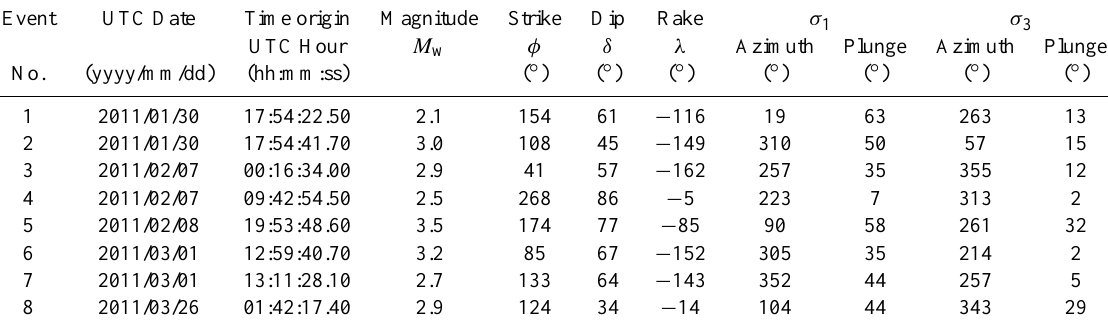
Fig. 4. (a) , (c) and (d) Observed and synthetic waveforms and their displacement amplitudes at each station for the largest earthquake M w = 3.5, 8 February 2011 at 19:53:48.6UTC. (b) Focal mechanism; first motion polarities are shown to compare with the best solution. Table 6. Earthquake source parameters and values of the maximum ( σ 1 ) and minimum ( σ 3 ) compressive principal stresses axes from the